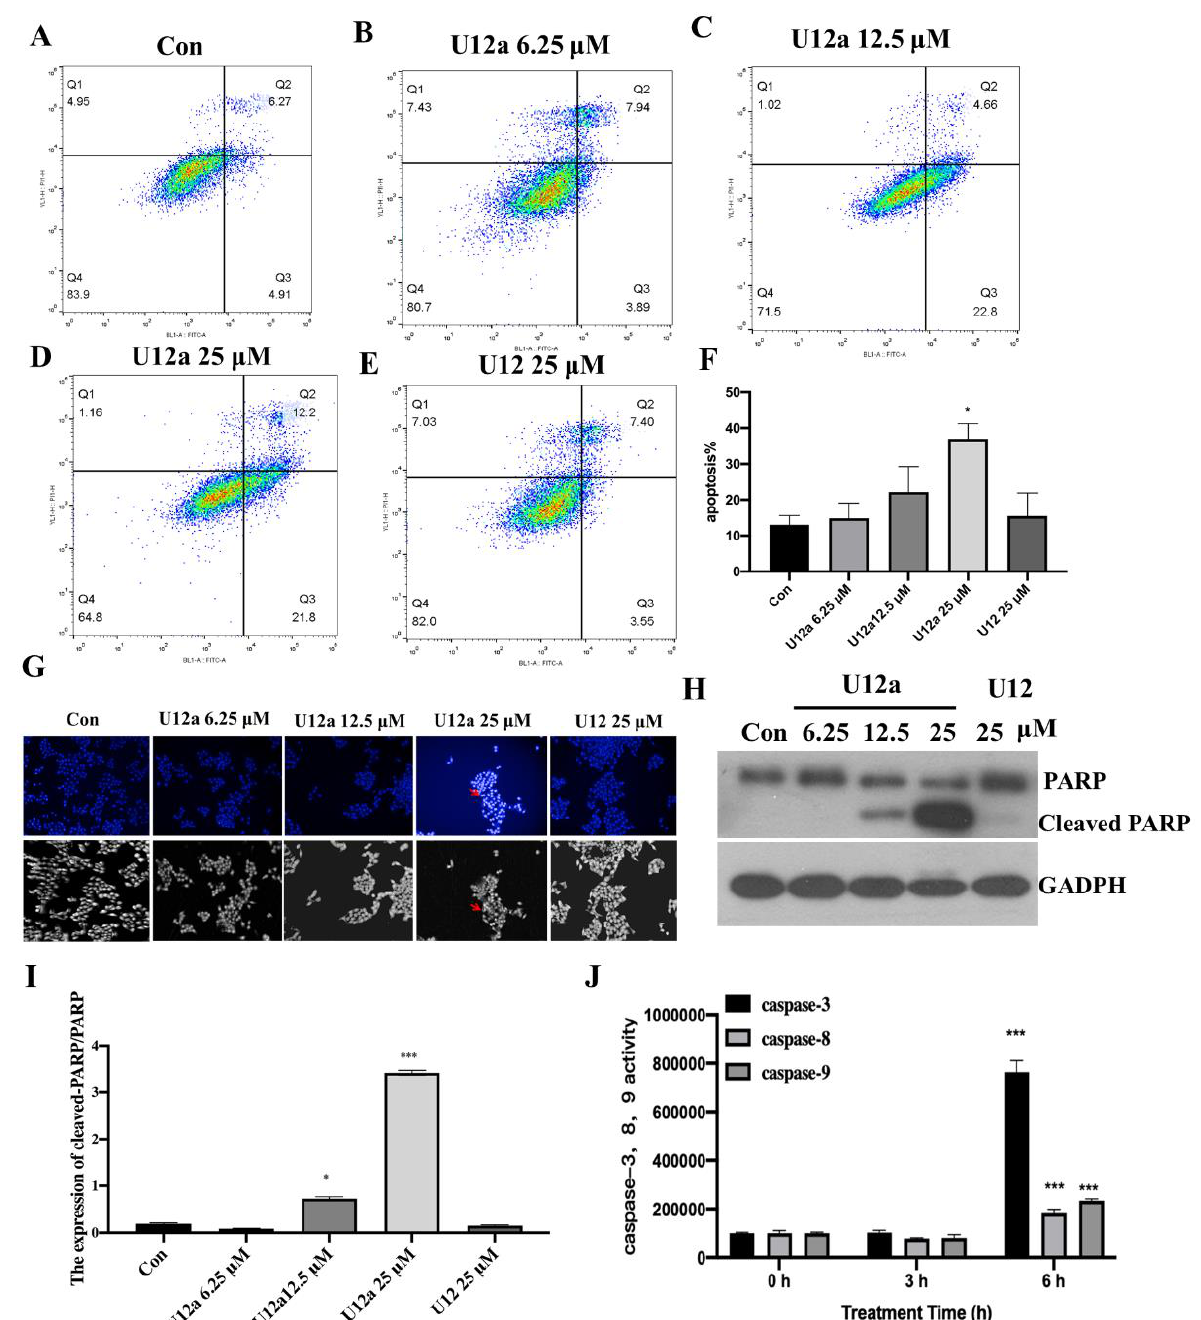
Figure 4. The pro-apoptosis effects of U12a on HepG2. ( A – F ) Flow cytometry assay to measure apoptosis of HepG2 by Annexin V-FITC/PI double staining method. HepG2 cells were treated with U12a at 0, 6.25, 12.5, and 25 µ M, and U12 at 25 µ M for 12 h. The cells were then stained with annexin V FITC (ANNEX300F) and ReadiDrop™ propidium iodide (1351101), and analyzed on a flow cytometer. The rate of early and advanced apoptosis can be seen in the bottom right quadrant (E3) and top right quadrant (E2), respectively. Dead cells can be seen in the top left quadrant (E1). Healthy cells are in the bottom left quadrant (E4). ( G ) Digital phase contrast and fluorescent micrographs of cells before and after U12a (6.25, 12.5, 25 µ M) or U12 (25 µ M) treatment for 12 h. Cell nuclei were stained with Hochest 33528. Apoptotic cells are labeled by red arrows. ( H , I ) PARP and cleaved PARP expression levels in HepG2 cells upon treatment of U12a (6.25, 12.5, 25 µ M) or U12 (25 µ M). ( J )The activities of caspase-3, -8, and -9, analyzed by caspase kits after treatment of U12a (25 µ M) for 6h. * p < 0.05 vs. control group. *** p < 0.001 compared with control or 0 h